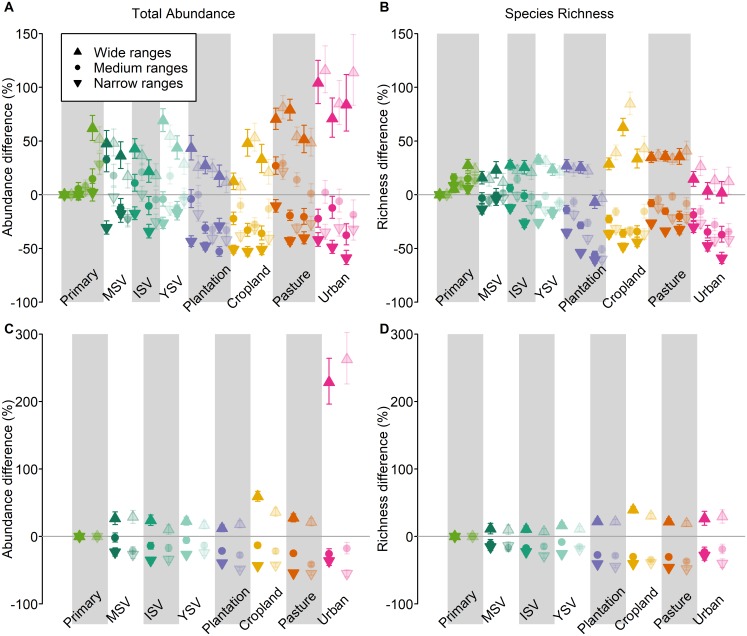
Effects of land-use type and land-use intensity on the total abundance or species richness of species with different range sizes.Effects are shown as a percentage difference relative to minimally used primary vegetation. Total abundance (A, C) and richness (B, D) are back-transformed to their original scales. For clarity, error bars here show ±1 standard error. The species sampled within each taxonomic Class within each survey were separated into 3 equal groups by range size into those with the widest ranges (upward-facing triangles), medium-sized ranges (circles), and narrowest ranges (downward-facing triangles). As in the main models, we either considered species’ abundance (i.e., modelling total abundance: A and C) or not (i.e., modelling species richness: B and D); we also considered 3 different metrics of range size for all species or for vertebrates only, with these combinations plotted as in Fig 2. The site-level data underlying the models shown here are freely available (DOI: 10.6084/m9.figshare.7262738). ISV, intermediate secondary vegetation; MSV, mature secondary vegetation; Plantation, plantation forest; Primary, primary vegetation; YSV, young secondary vegetation.